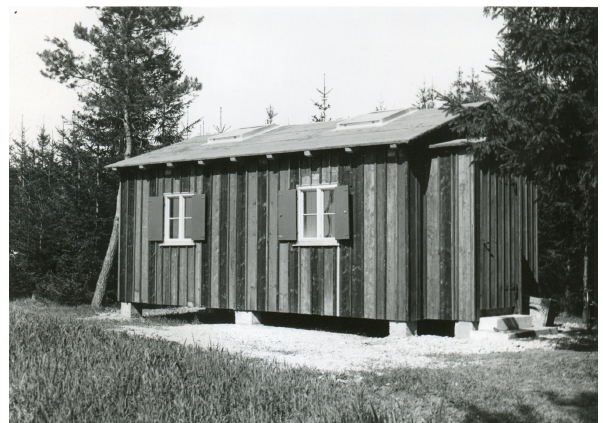
Figure 12. Simple wooden hut (Maisacher Hütte) which served as a storage room for the equipment after 1923 and later also as a pro- visional measuring site for the observatory in